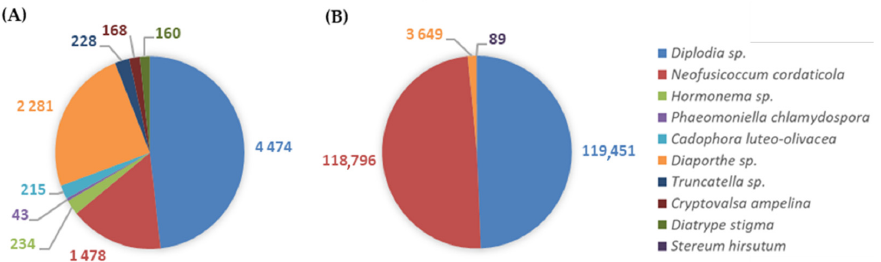
Figure 6. Distribution of GTDs-associated fungi illustrating the respective number of reads identified in: ( A ) symptomatic and ( B ) asymptomatic grapevines to trunk diseases.